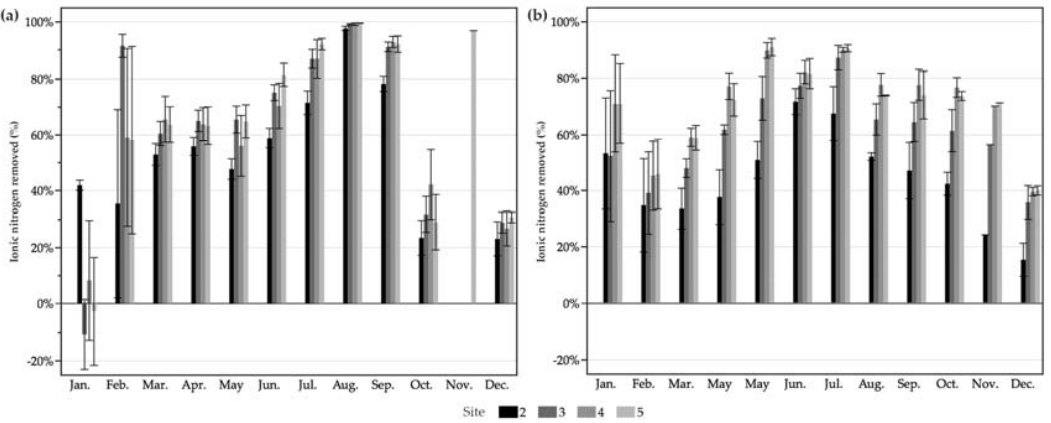
Figure 5. Average ionic nitrogen removal efficacy in: Constructed Wetland 1 ( a ); and Constructed Wetland 2 ( b ). Sites within Constructed Wetland 1 include outflow from Stage 1 (Site 2), outflow from Stage 2 (Site 3), runoff ditch with effluent exiting Stage 2 (Site 4), and the stilling pond (Site 5). Sites within Constructed Wetland 2 include outflow from Stage 1 (Site 2), outflow from Stage 2 (Site 3), outflow from Stage 3 (Site 4), and the stilling pond (Site 5). Error bars represent the standard error ( ± ) of the mean value.